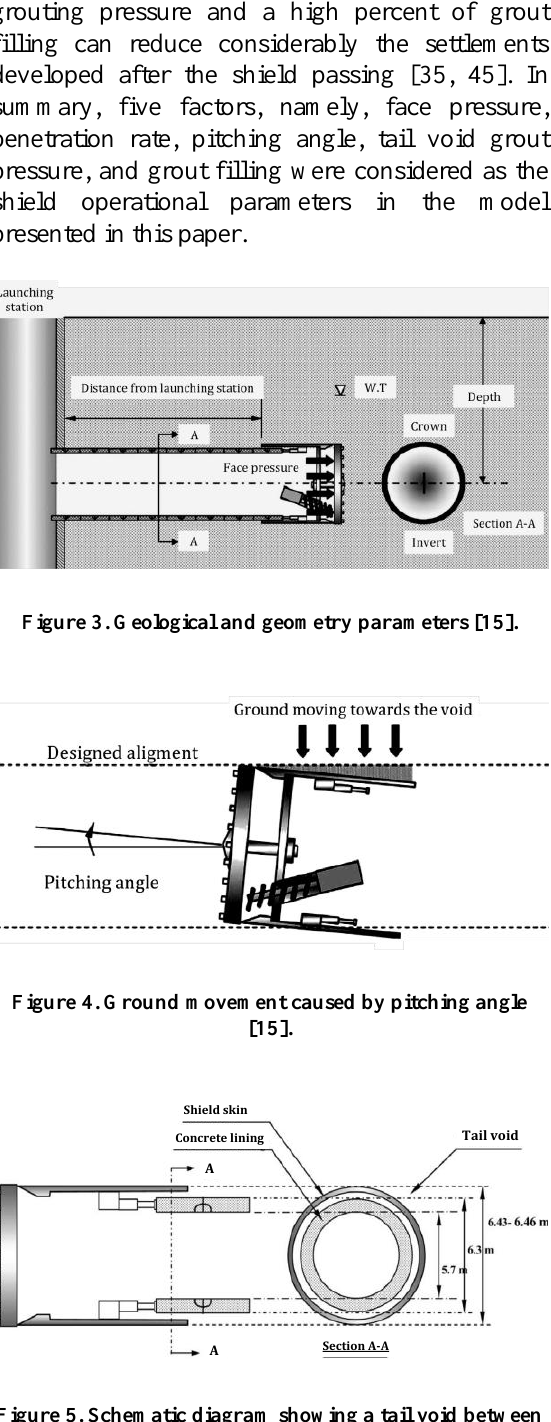
Figure 5. Schematic diagram showing a tail void between tunnel lining and liner [15].